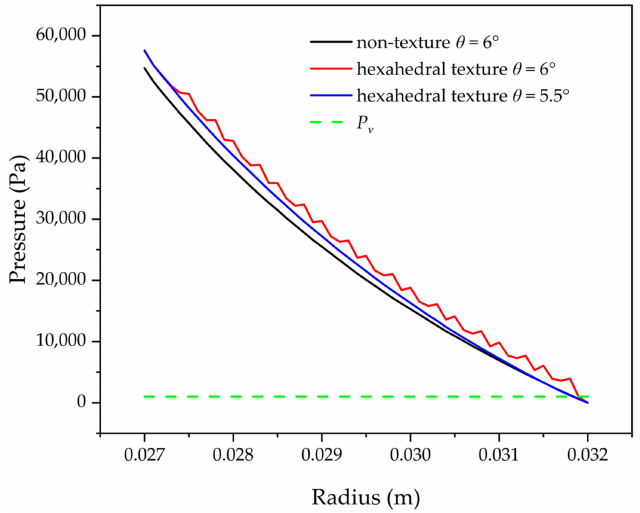
Figure 26. Radial pressure distribution of oil